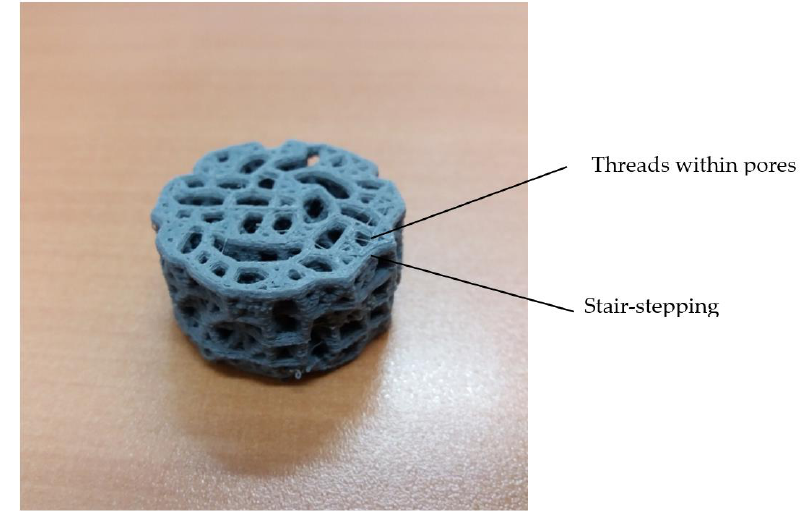
Figure 8. Printed porous structure (rescaling of the designed scaffold by scaling factor of five).